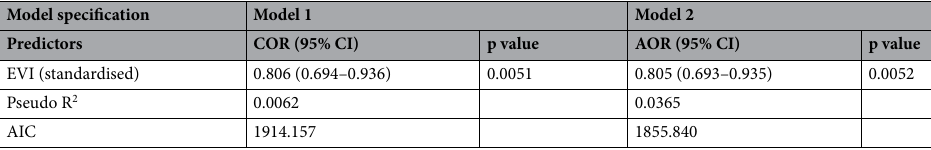
Table 2. Association between residential area greenness (1 SD increase in EVI) and diabetes among adults in Bangladesh. COR crude odds ratio, AOR adjusted odds ratio, CI confidence interval, EVI enhanced vegetation index, AIC Akaike information criteria; Model 2 is adjusted for individual-level age, sex, education status, working status, and marital status.